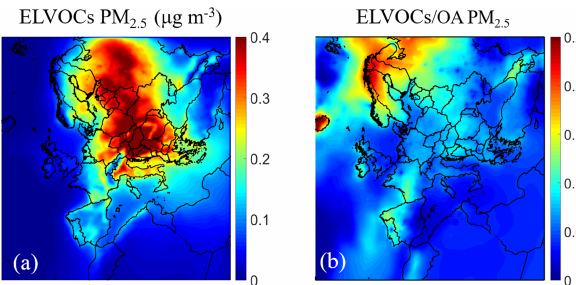
Figure 3. Average ground level (a) PM 2 . 5 ELVOCs mass concen- tration (in µgm − 3 ) and (b) the ratio of the PM 2 . 5 mass of ELVOCs to OA during the simulation. Different scales are used.